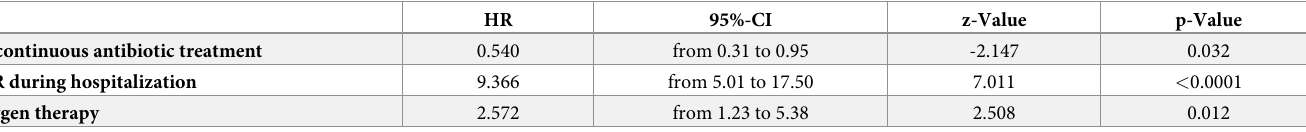
Table 9. Hazard ratio (HR) estimates from the cause-specific Cox proportional-hazards model on time to death with findings during hospitalization as explanatory